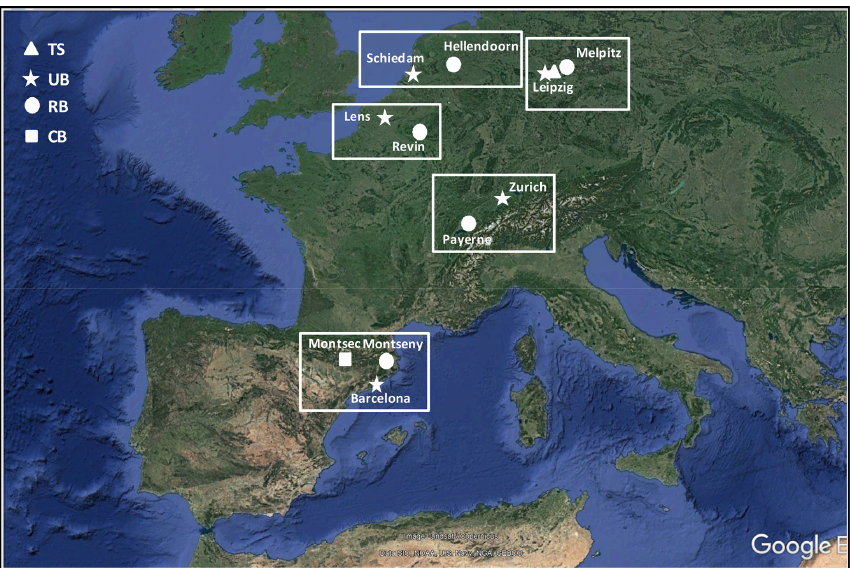
Figure 1. Paired sites included in this work. TS: traffic station (DE). UB: urban background (NL, DE, FR, CH, ES). RB: regional background (NL, DE, FR, CH, ES). CB: continental background (ES). © Google